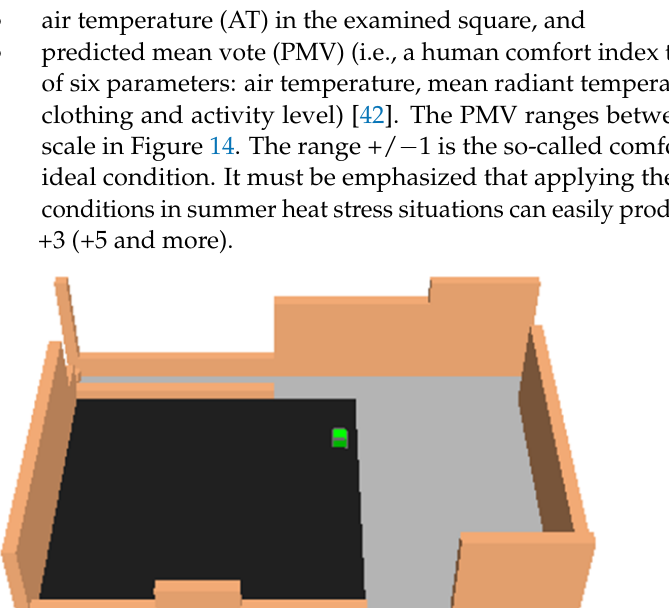
Figure 12. Traditional sampietrini pavement over all the square (S2). Figure 13. Permeable and traditional sampietrini pavement (S3).